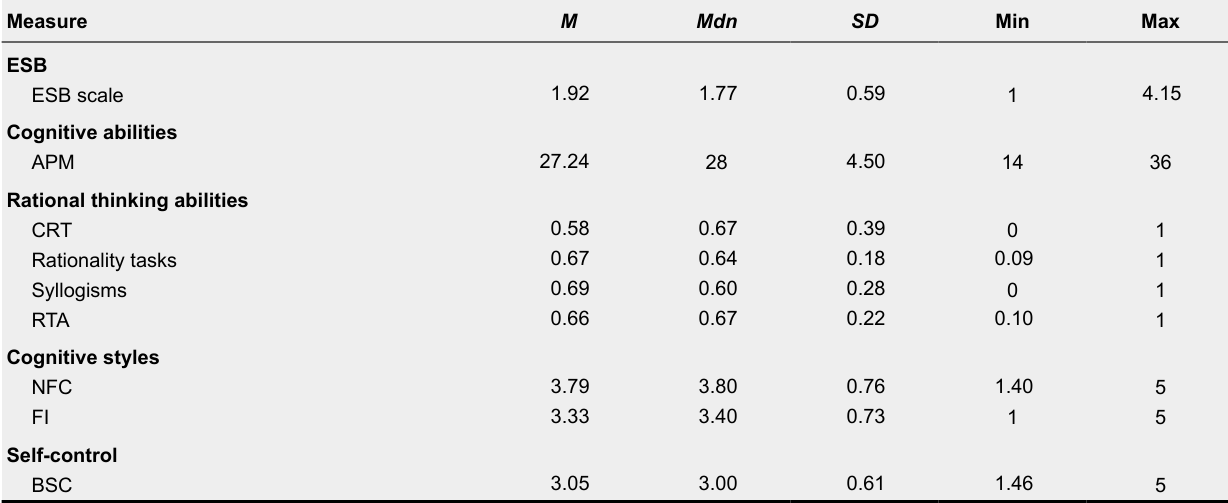
Descriptive Statistics and Reliability Coefficients of the Measures Used in the Study Measure